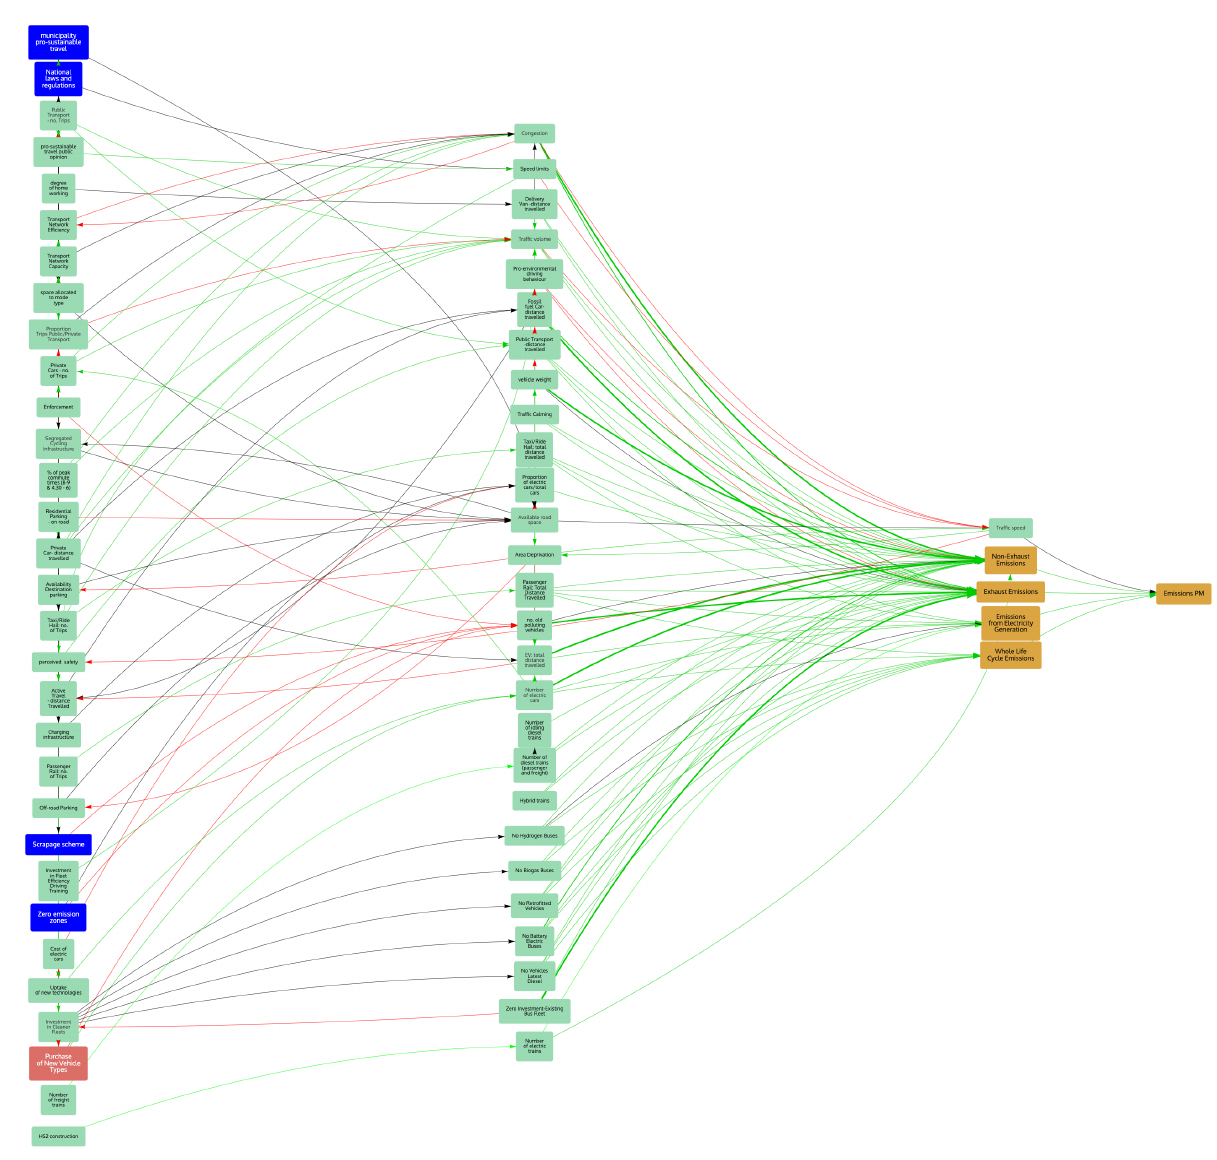
Figure 7. PM emissions: upstream 3